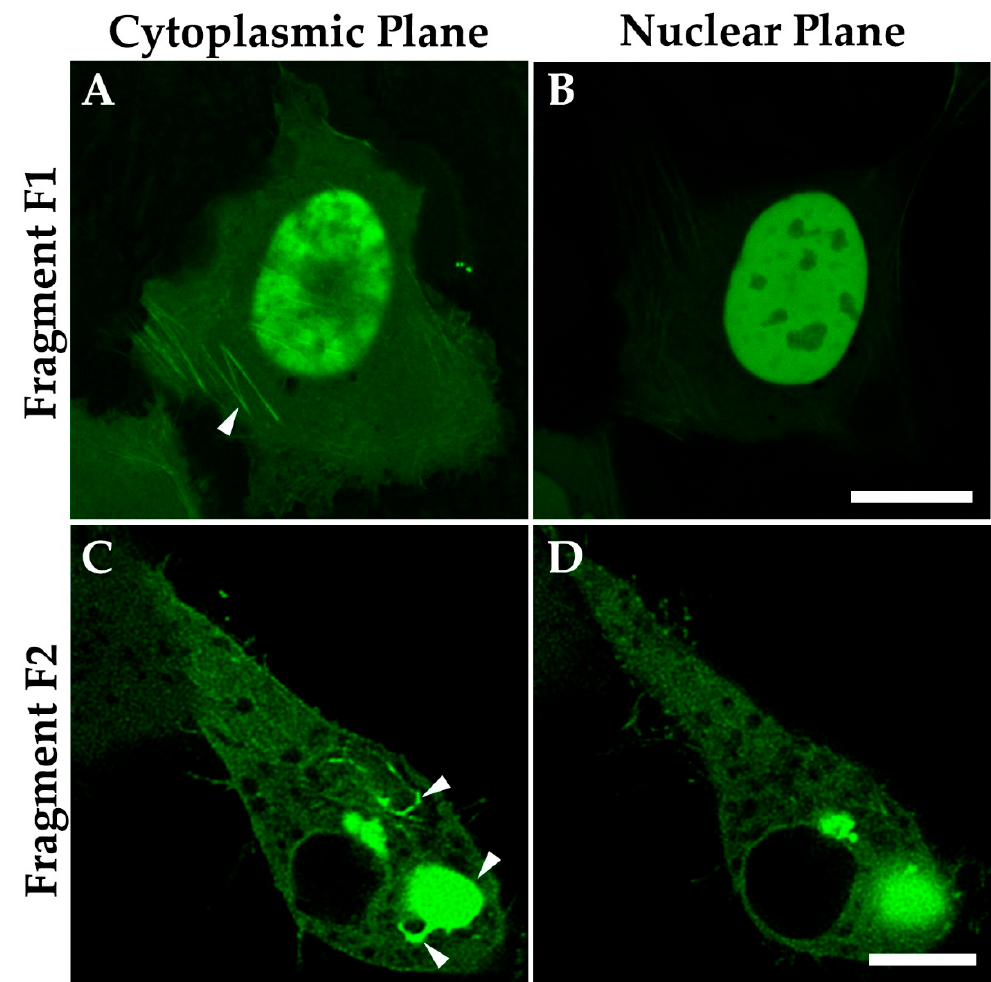
Figure 10. Confocal microscopy revealed the sub-cellular localization of the overexpressed GFP-MPRIP fragments F1 and F2. Fragment F1 localizing to ( A ) stress fibers and ( B ) to nucleus. Fragment F2 shows ( C ) globular and fibrous structures in the cytoplasm but not in the ( D ) nucleus. Scale bars represent 10 µm.